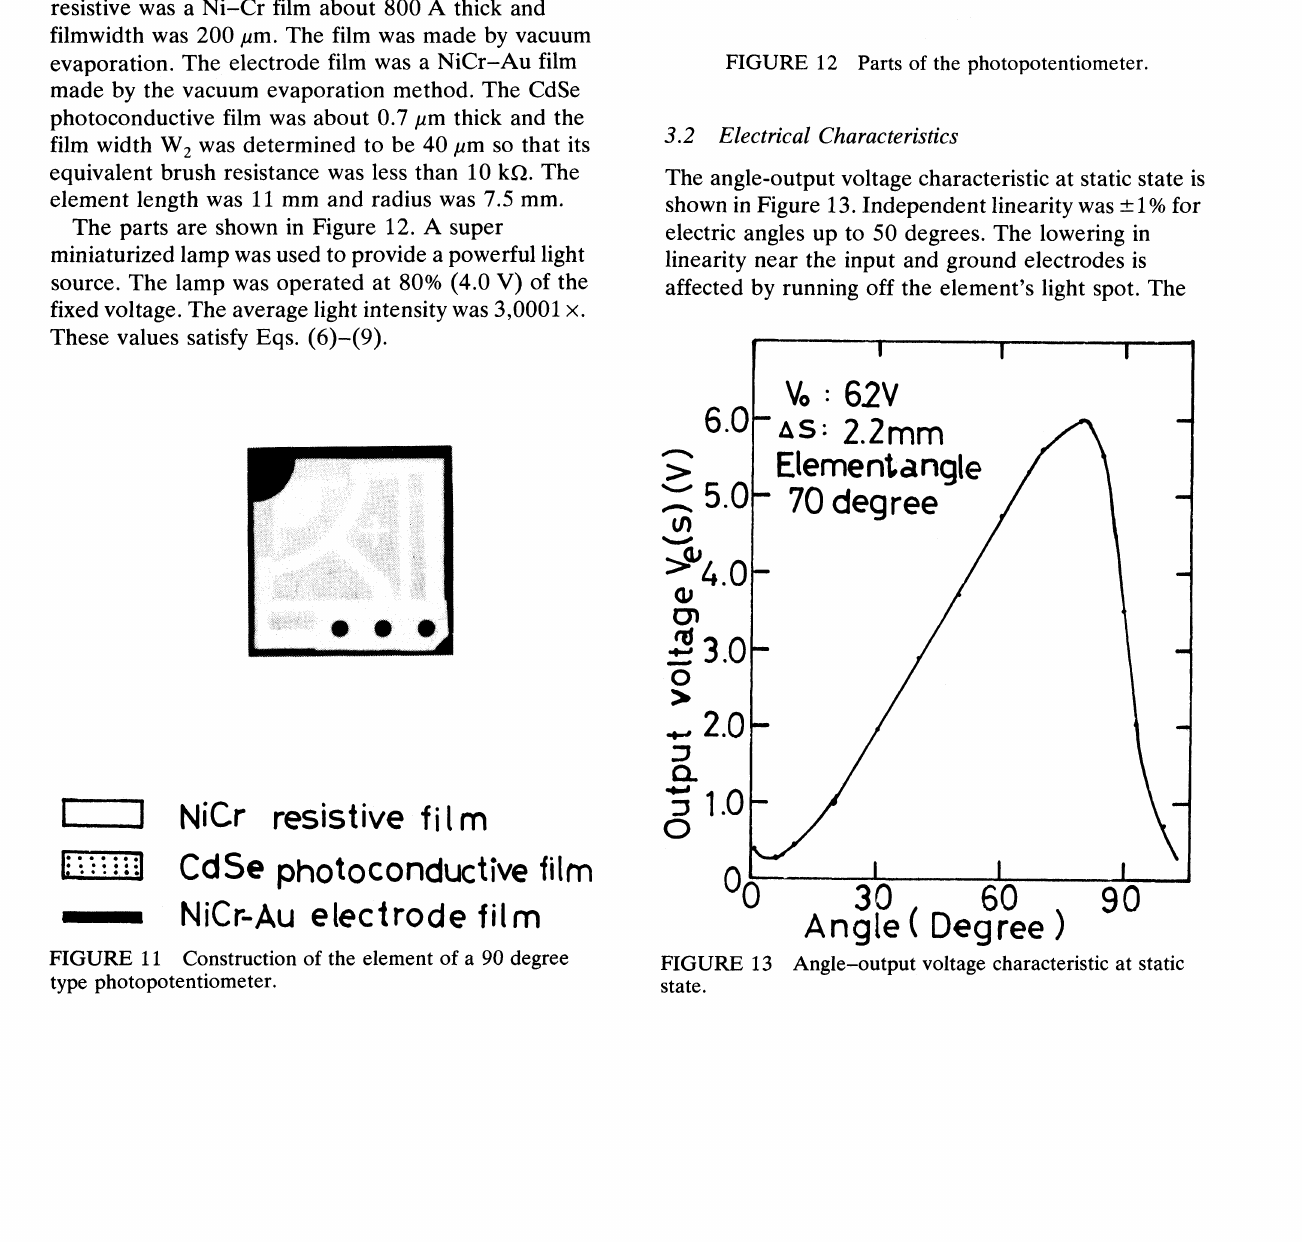
FIGURE 12 Parts of the photopotentiometer.